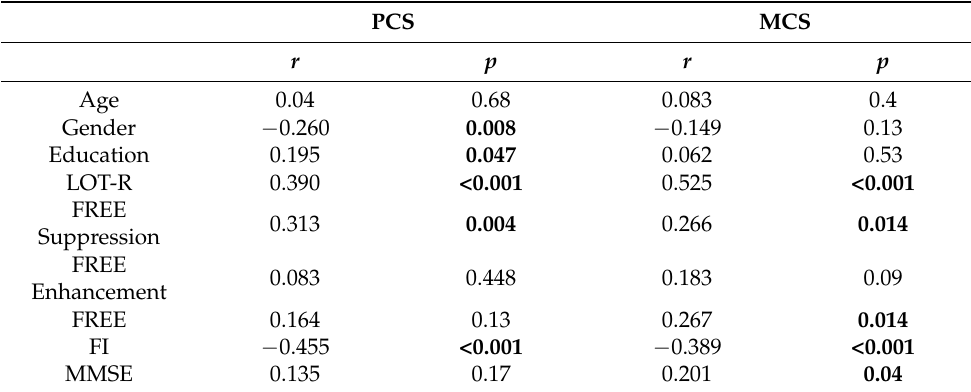
Table 2. Main correlations between the variables investigated at